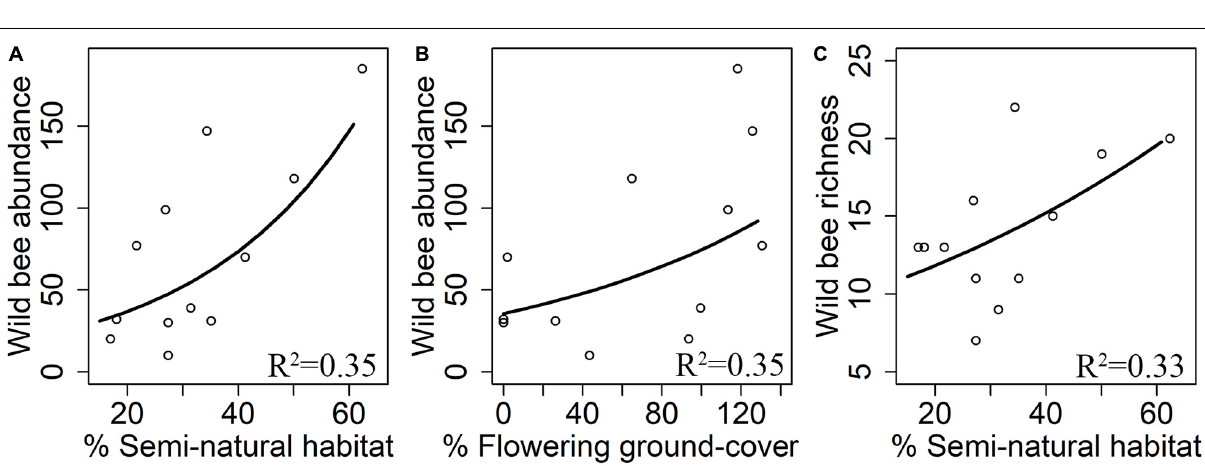
FIGURE 3 | Responses of seed number to bees (A) and the effect of seed number on deformation (B) . R 2 means adjusted R -squared of the final model.